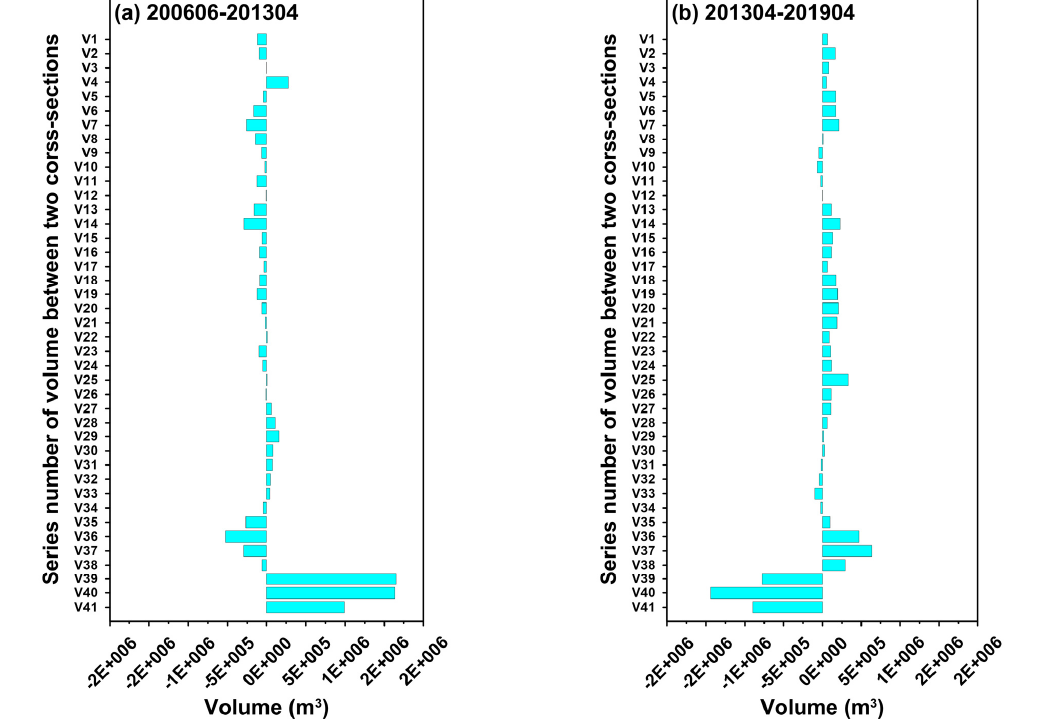
Figure 6. The erosion and accretion volume between each pair of cross sections during the period of (a) June 2006 to April 2013 and (b) April 2013 to April 2019.